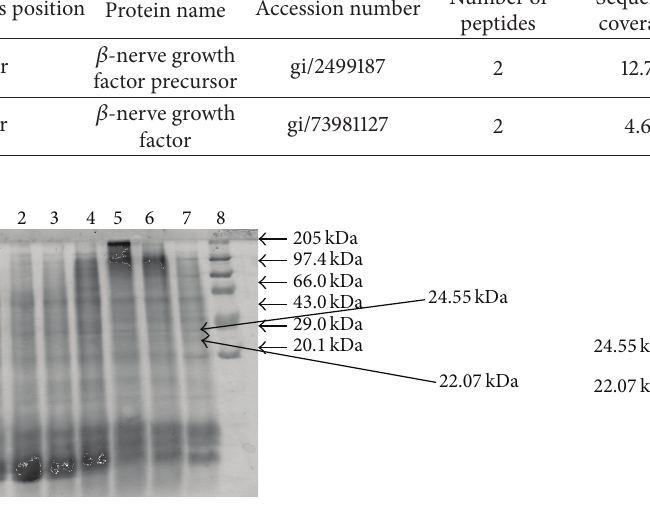
Figure 1: Protein profiles of fresh and liquefied semen. Lane 1, 0 hours; lane 2, 6 h; lane 3, 12 h; lane 4, 18 h; lane 5, 24 h; lane 6, 30 h; lane 7, 36 h; and lane 8, protein markers.